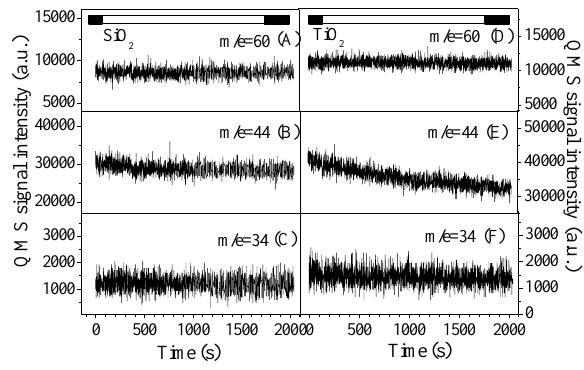
Fig. 4. The heterogeneous reactions of OCS on 350.5mg SiO 2 and 400.0mg TiO 2 , respectively. The left side is the uptake curve of OCS by SiO 2 , and the right side is the uptake curve of OCS by TiO 2 .